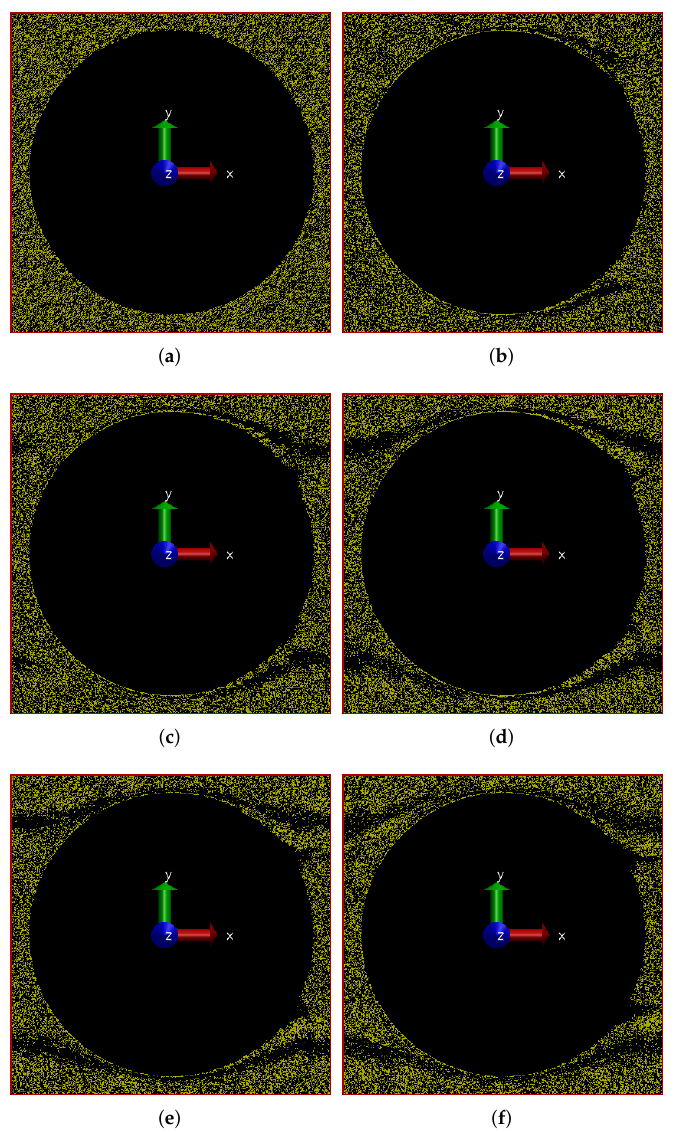
Figure 1. Snapshots of simulation (in beam-view) at different times showing development of polymer positions over time for flow through a cylindrical porous medium with pressure applied in the positive x -direction. ( a ) t = 0 s; ( b ) t = 25 s; ( c ) t = 50 s; ( d ) t = 100 s; ( e ) t = 150 s; ( f ) t = 200